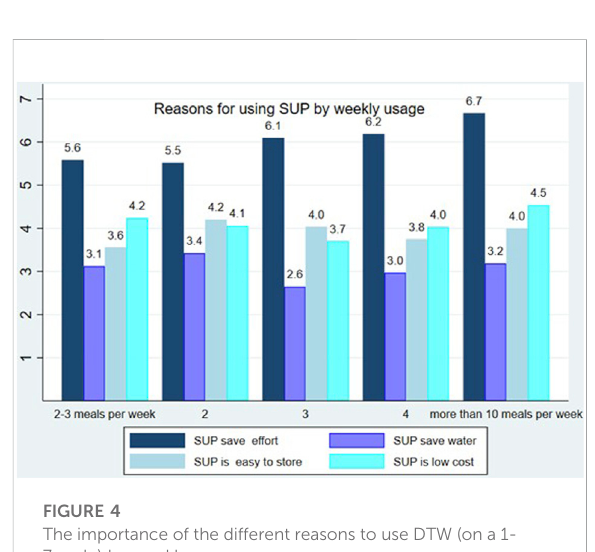
FIGURE 4 The importance of the different reasons to use DTW (on a 1- 7 scale) by weekly usage.